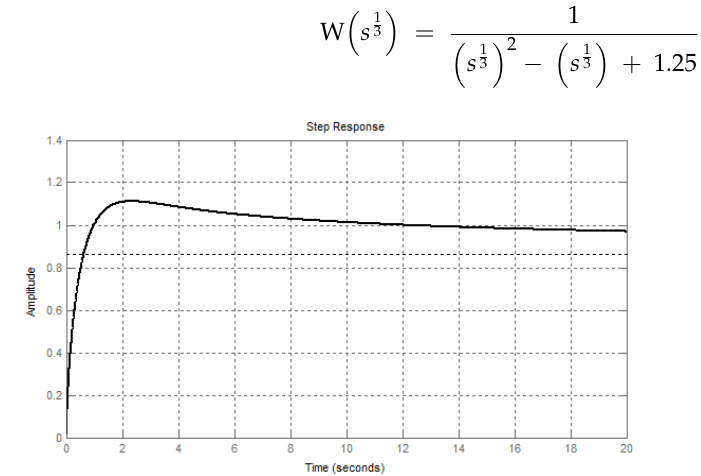
Figure 19. The transition function in this case.